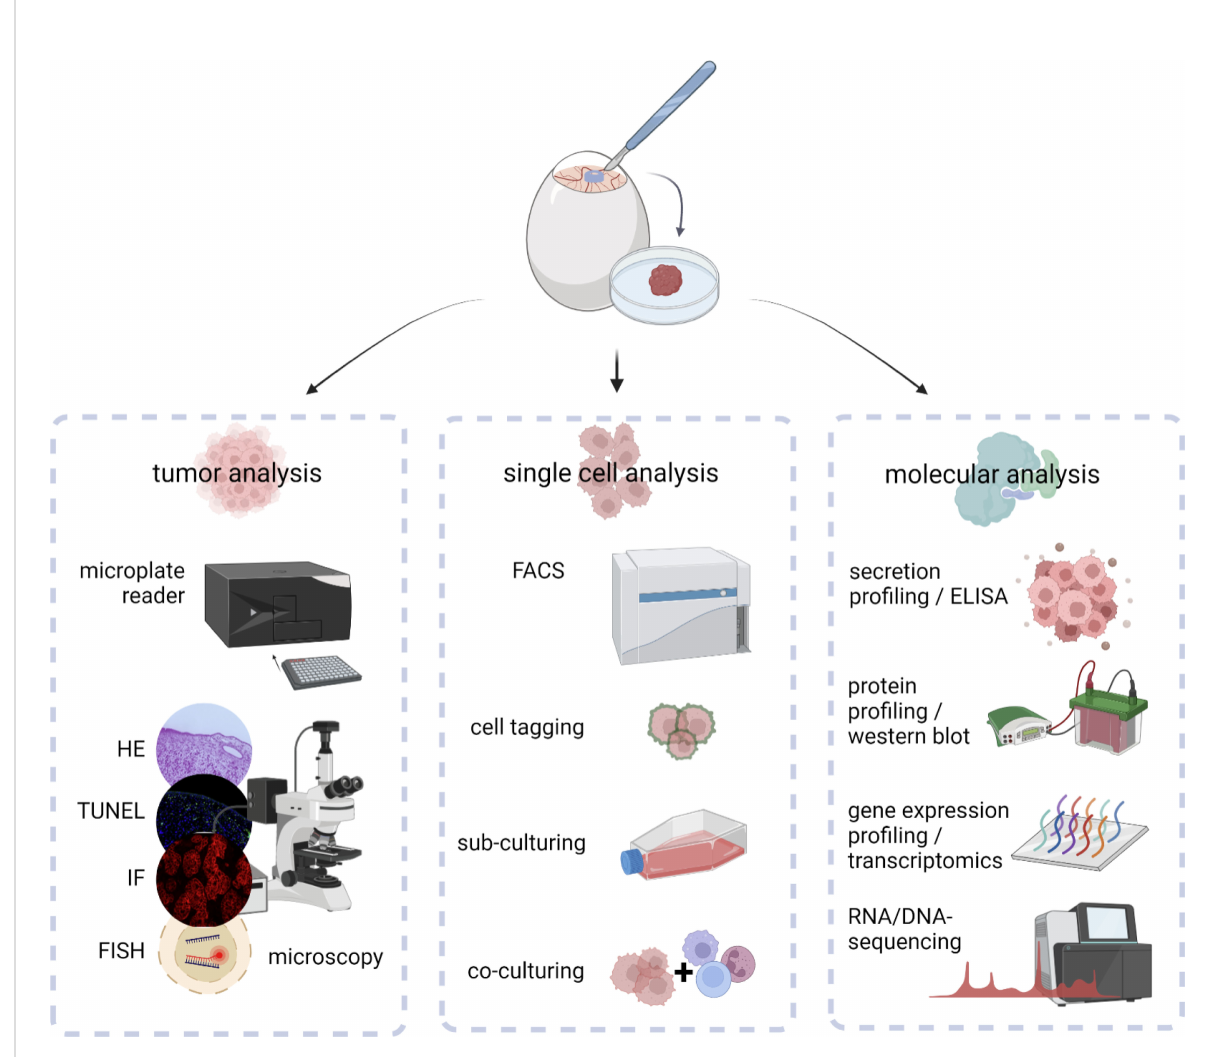
FIGURE 3 Downstream analysis of excised in ovo- grown tumors at macroscopic, cellular, and molecular